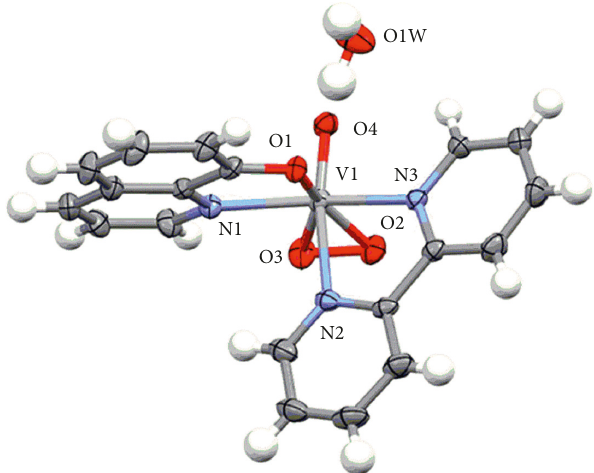
Figure 1: MERCURY drawing of complex 2 . Thermal ellipsoids drawn at 30% probability level.